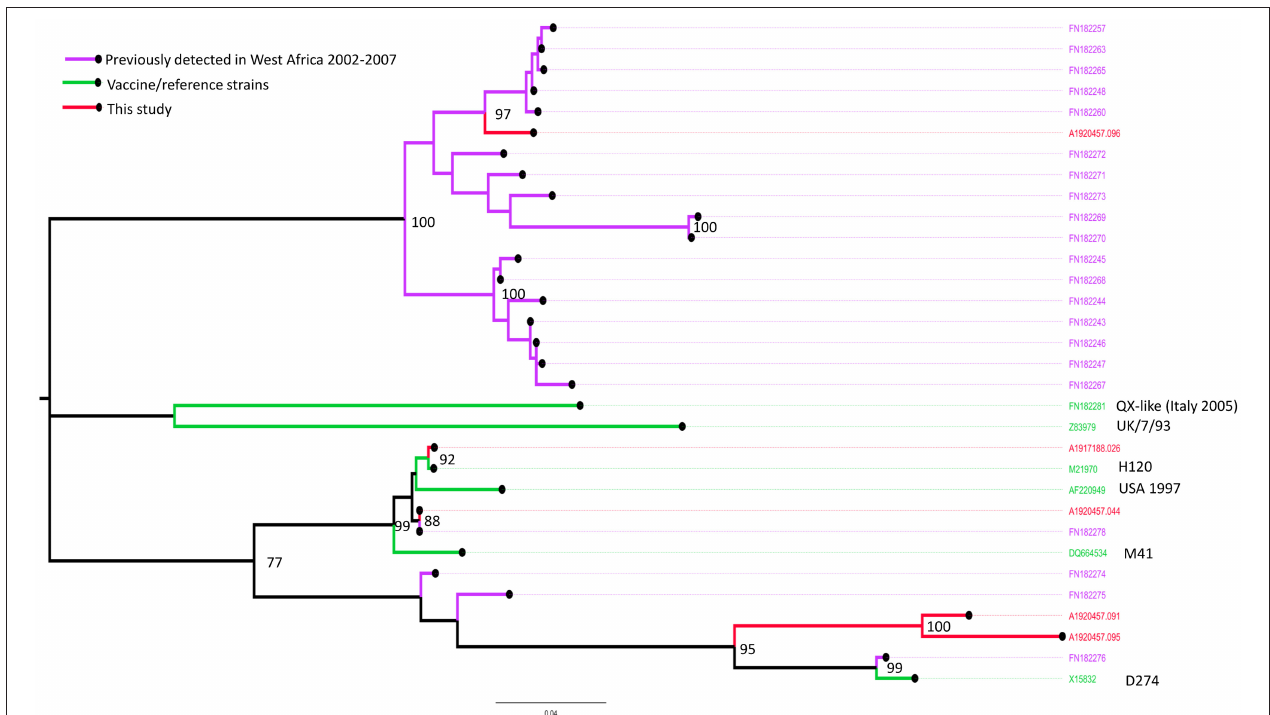
FIGURE 5 | Maximum likelihood phylogenetic tree of a 470 nucleotide region of 32 sequences implemented in MEGA-X, showing the relationships between the IBV isolates obtained from Farms 7 (sample ref: A1920457.091), 11 (A1920457.095), 12 (A1920457.096), 16 (A1920457.044), and 35 (A1917188.026), based on the amplified partial nucleotide sequence coding for the S1-spike protein of Infectious Bronchitis Virus (IBV) and selected reference sequences. Study sequences are shown in red. Bootstrap values (percentage of 500) over 85 are